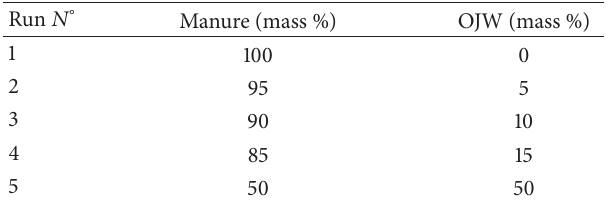
Table 2: Manure/OJW ratios exploited to perform the anaerobic digestion of agroindustry